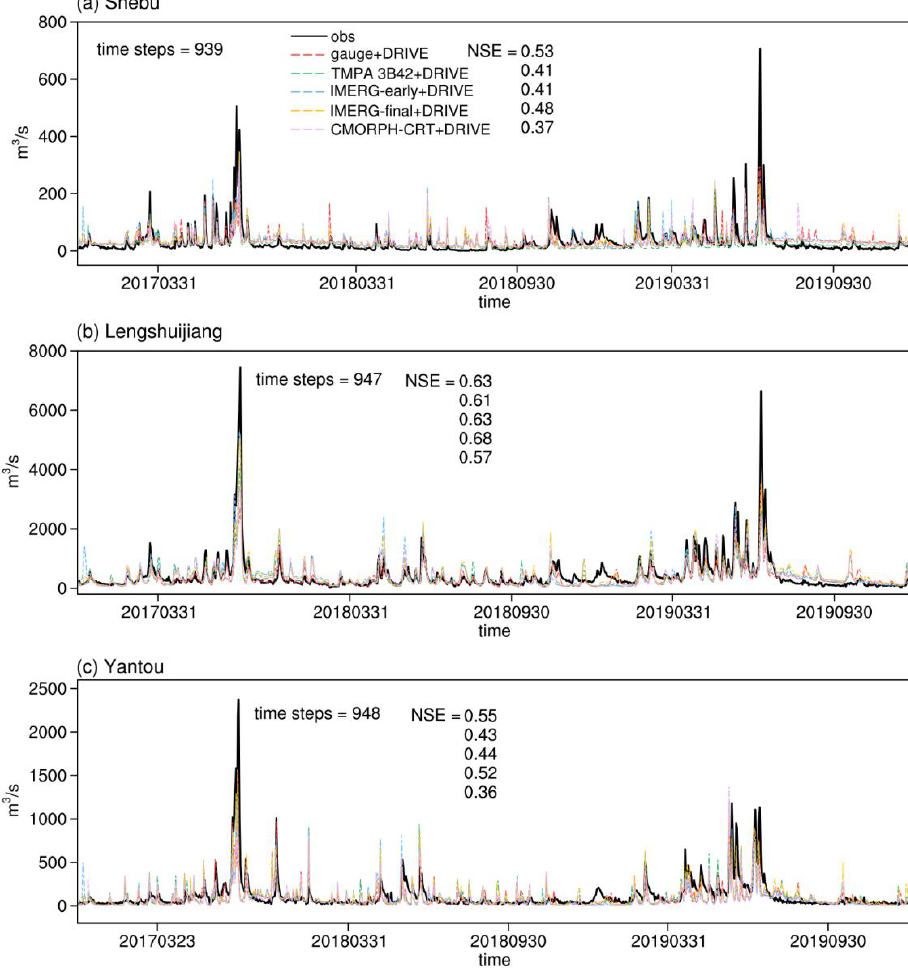
Figure 6. Simulated and observed streamflow at the four gauges. 3.3. A Case Study of Typhoon Bailu The satellite-based precipitation estimation performance, as well as the hydrological application of gauge- and satellite-based precipitation during Typhoon Bailu are evalu- ated. As shown in Figure 7, Typhoon Bailu, which originated on 20 August 2019 (UTC), first landed in Taiwan on 24 August; it then landed in Fujian on 25 August and, eventu- ally, dissipated in Hunan on 26 August. We evaluated the associated performance of